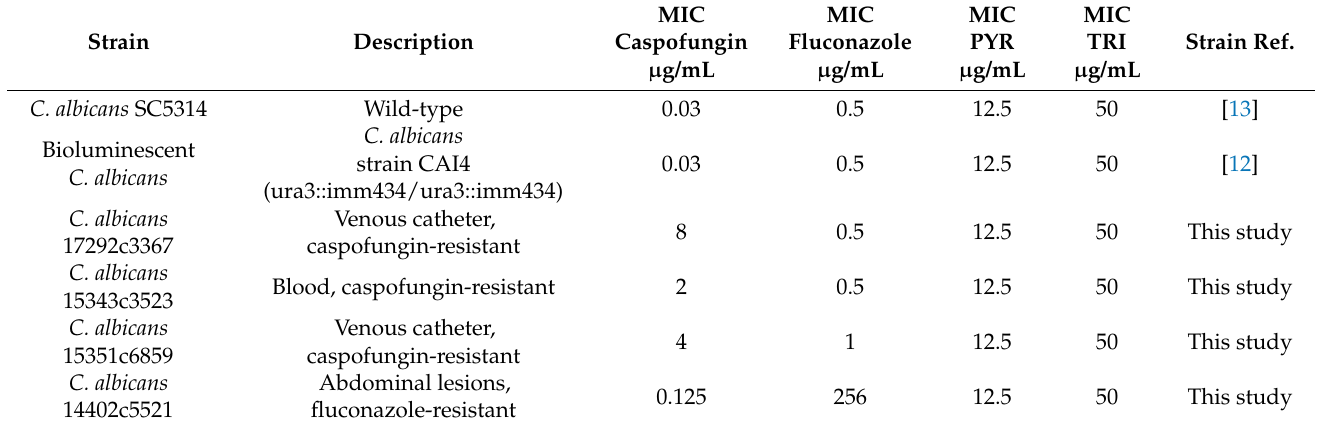
Table 2. Antifungal activity of PYR and TRI versus caspofungin and fluconazole.